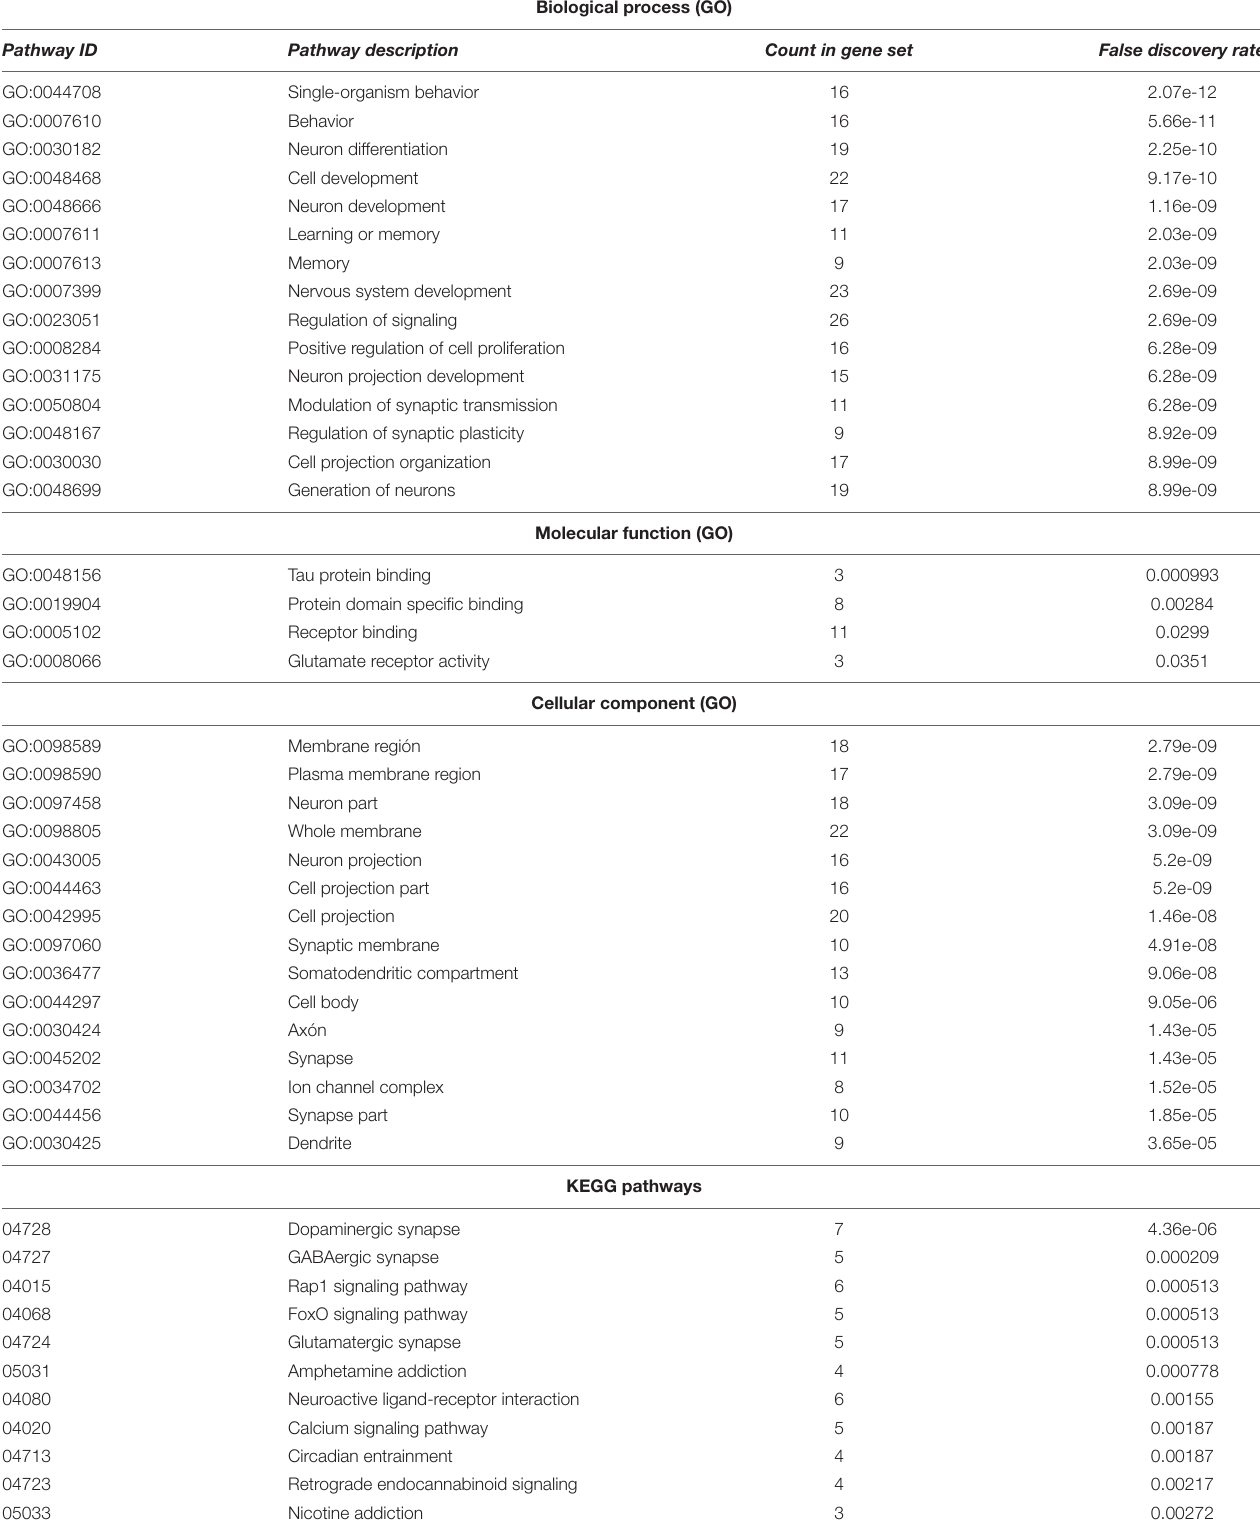
TABLE 2 | Functional enrichment of the entire set of candidates for the oscillogenome according to Gene Ontology (GO) consortium annotations. Biological process